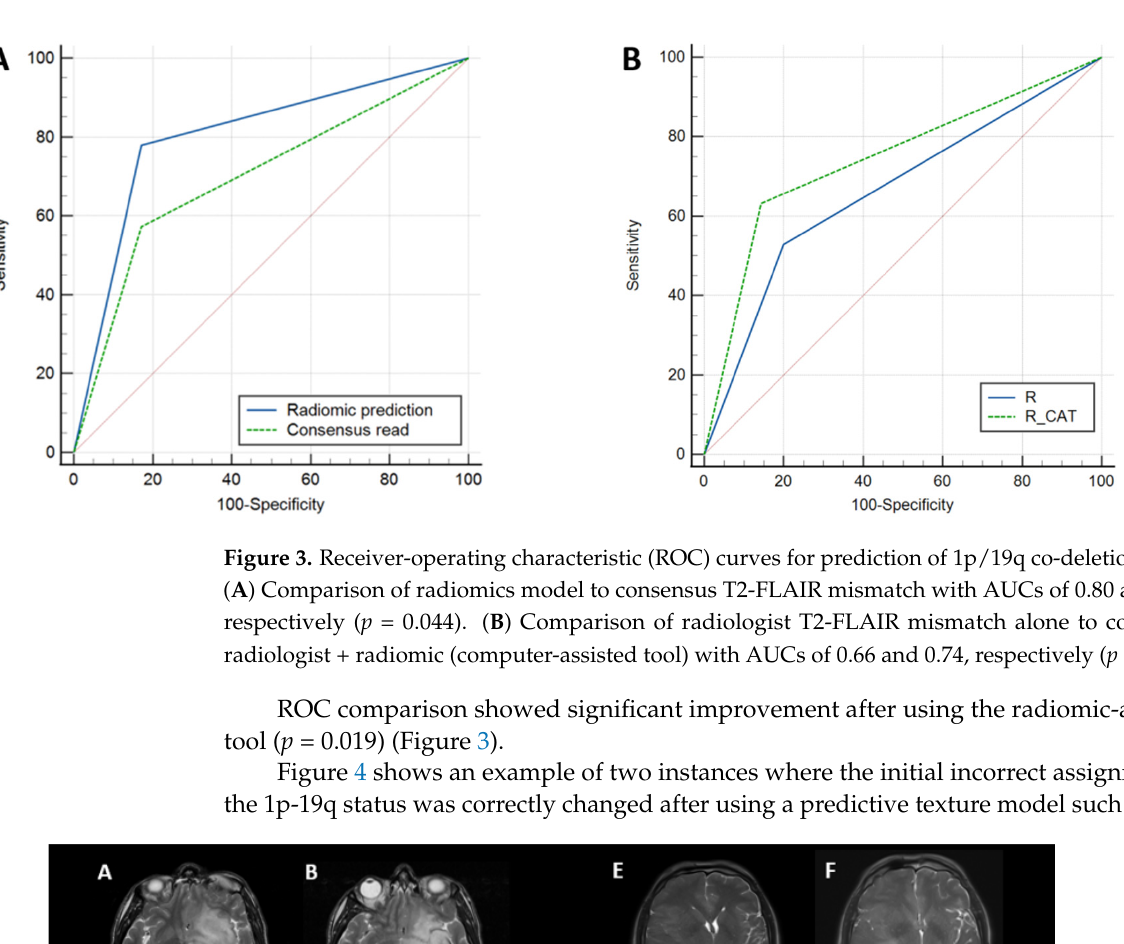
7 of 12 Figure 2. Examples of T2 ‐ FLAIR match and mismatch in 4 patients with IDH1 mutant gliomas with various 1p/19q co ‐ deletion status. Axial T2 ( A ) and FLAIR ( B ) images demonstrate T2 ‐ FLAIR mismatch in a 25 ‐ year ‐ old male with 1p/19q non ‐ co ‐ deletion correctly identified in a true positive instance. Axial T2 ( C ) and FLAIR ( D ) images demonstrate T2 ‐ FLAIR mismatch in a 58 ‐ year ‐ old female with 1p/19q co ‐ deletion in a false positive instance. Axial T2 ( E ) and FLAIR ( F ) images show T2 ‐ FLAIR match in a 55 ‐ year ‐ old male with 1p/19q non ‐ co ‐ deletion in a false negative instance. Axial T2 ( G ) and FLAIR ( H ) images show T2 ‐ FLAIR match in a 60 ‐ year ‐ old female with 1p/19q non ‐ co ‐ deletion correctly identified in a true negative instance. All cases were correctly identified by radiomic model. 3.3. Radiomic ‐ Based Prediction of 1p/19q Co ‐ deletion Status Using a radiomic ‐ generated model from a combination of six texture features (first ‐ order uniformity, gray ‐ level run ‐ length matrix run percentage, neighborhood gray tone difference matrix coarseness, first ‐ order energy, gray ‐ level co ‐ occurrence matrix cluster prominence, and neighborhood gray tone difference matrix strength) the diag ‐